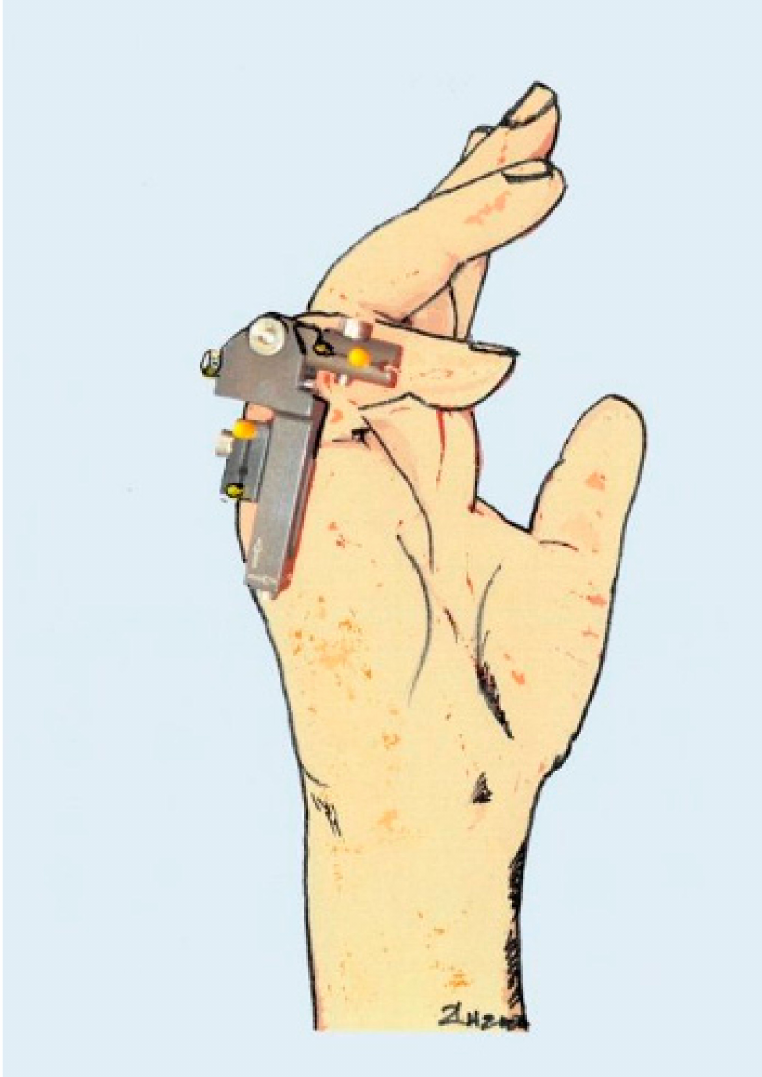
Figure 2. Erlangen miniaturized distraction device with turning worm-screw mechanism (copyright R E Horch